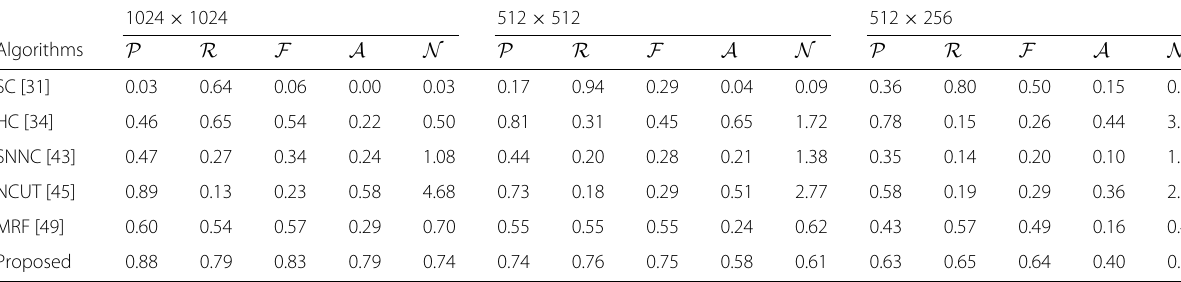
Table 5 Comparison of clustering algorithms on D 5